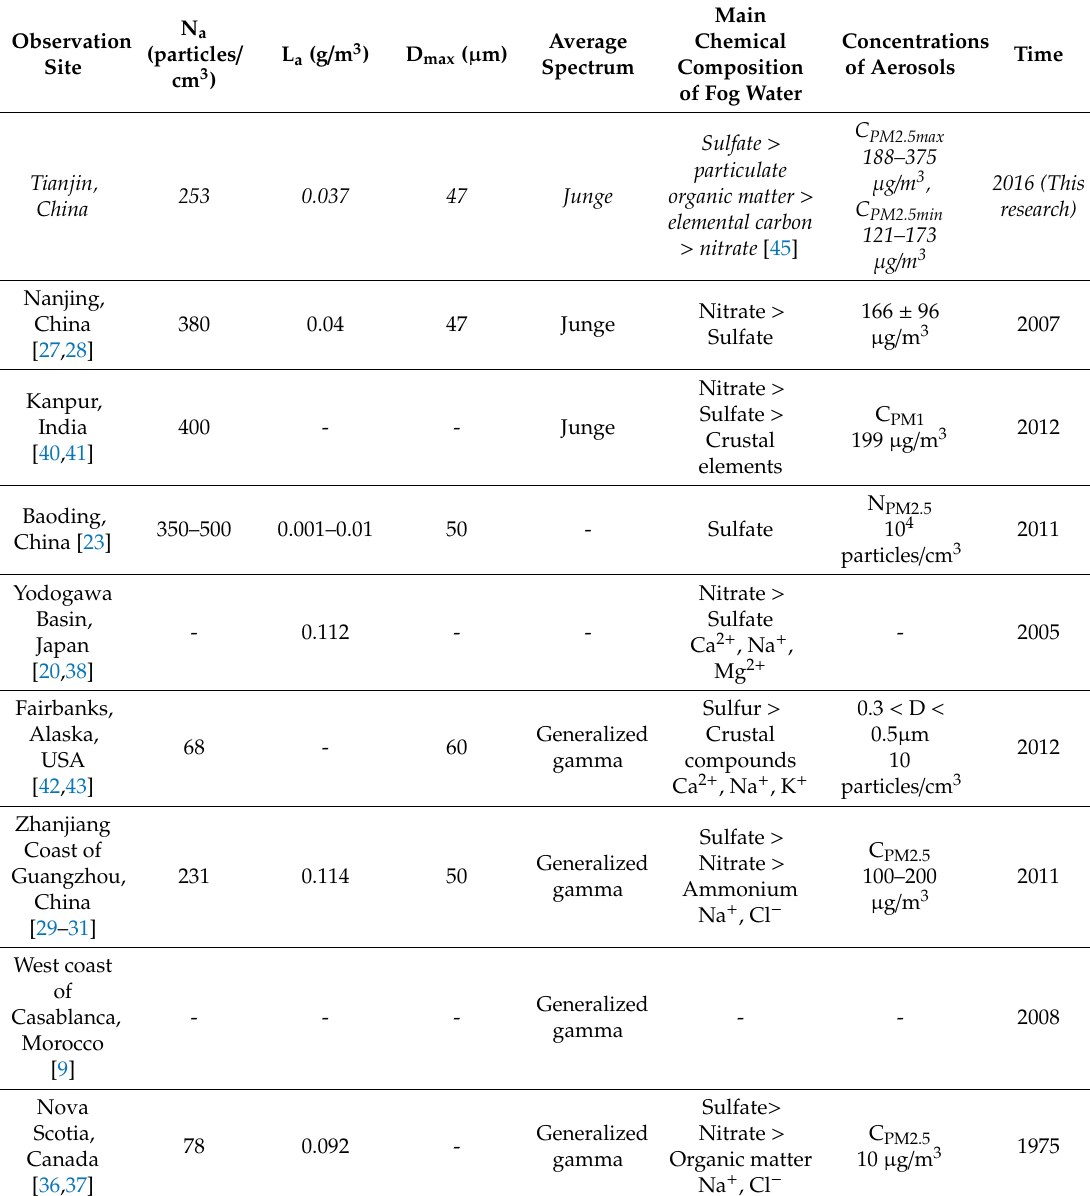
Table 3. Microphysical characteristics of dense fog processes, the main chemical composition of fog water and the concentrations of the main aerosols in several coastal and inland cities around the